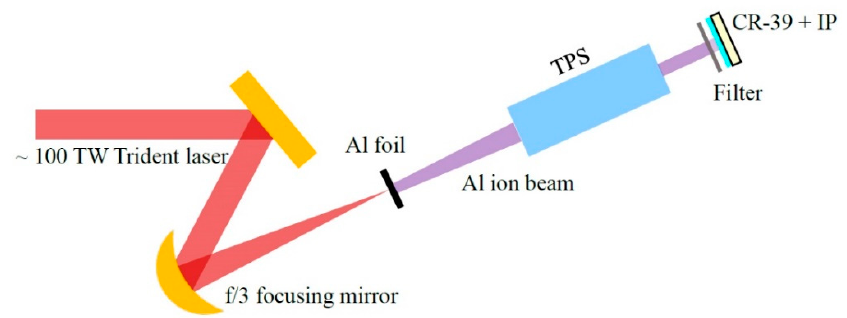
Figure 1. Schematic layout of the experimental setup. An intense laser pulse produces energetic Al ions, which are detected using CR-39 and IP.